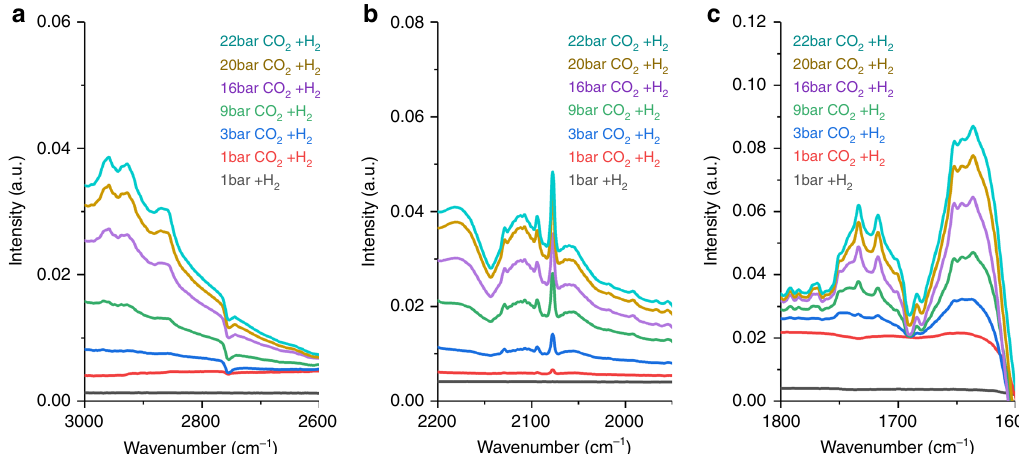
Fig. 6 In situ IR spectra of Cu/UiO-66-a exposed to CO 2 and H 2 . We used a CO 2 /H 2 mol ratio of 1:3 from 1 to 22 bar at 200 °C. a Range of 3200 – 2600 cm − 1 showing the formation of methoxy groups; b range of 2200 – 1950 cm − 1 showing CO species adsorbed on various types of Cu sites; c and range of 1800 – 1600 cm − 1 showing the formation of bicarbonate/carbonate species. The colors of the lines match the color of the conditions described in the